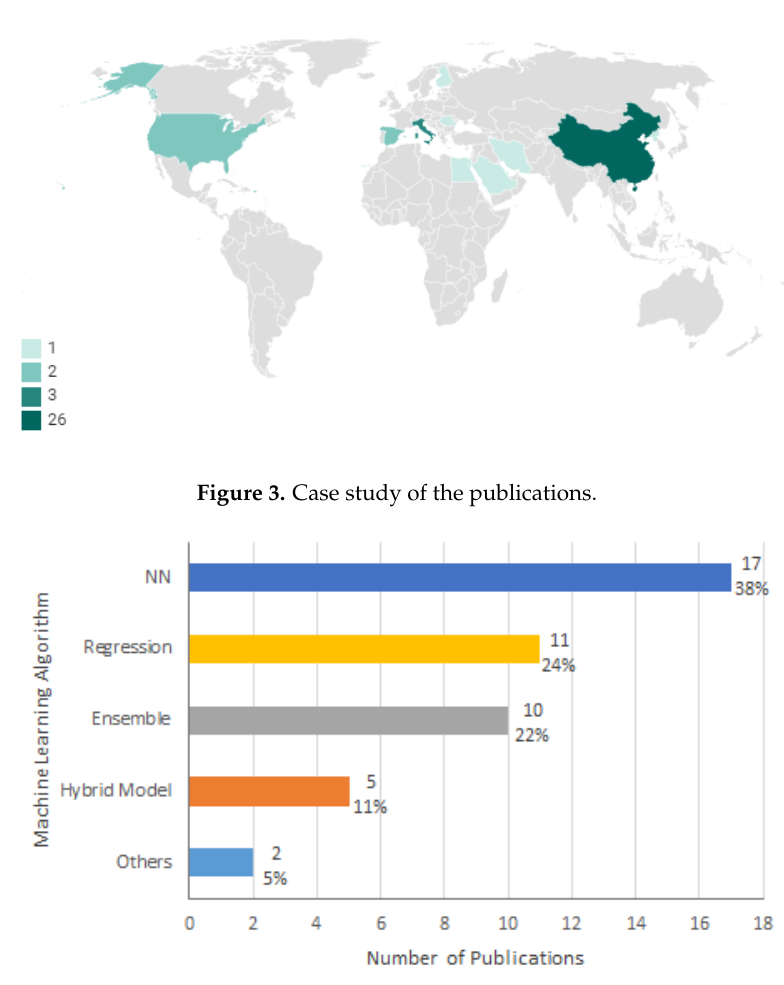
Figure 4. Used machine learning